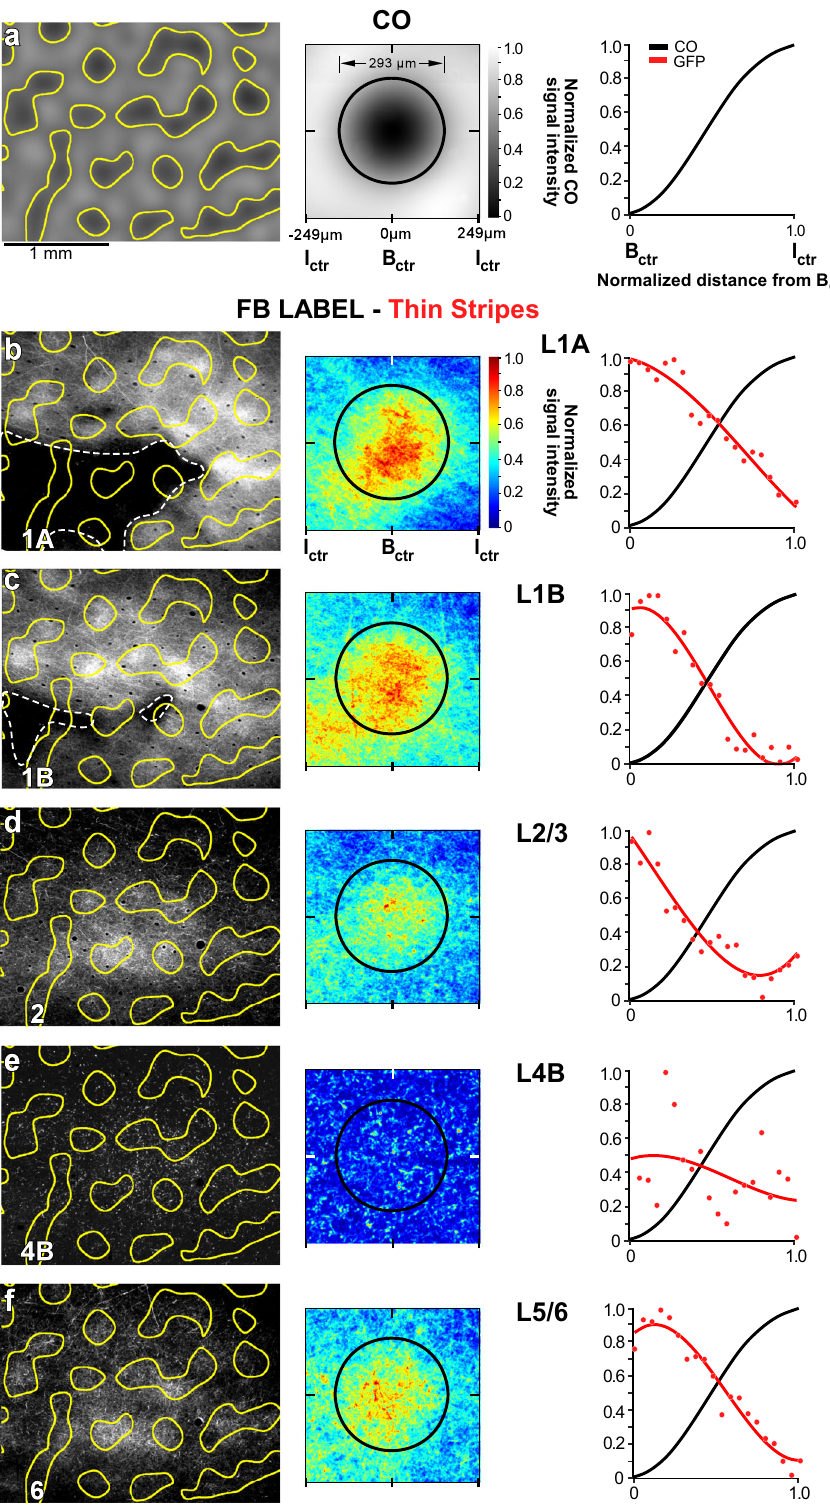
Fig. 5 V2 thin stripes project to V1 blobs. Case MK356RH. Same as in Fig. 4, but for GFP-labeled FB axons in V1 resulting from the AAV9-GFP injection site in a V2 thin stripe shown in Fig. 3. In all layers, GFP-label intensity dominates inside blobs. Results in ( a – f ) are representative of three independent injections centered in thin stripes. Source data for right panels in ( a – f ) are provided as a Source data fi